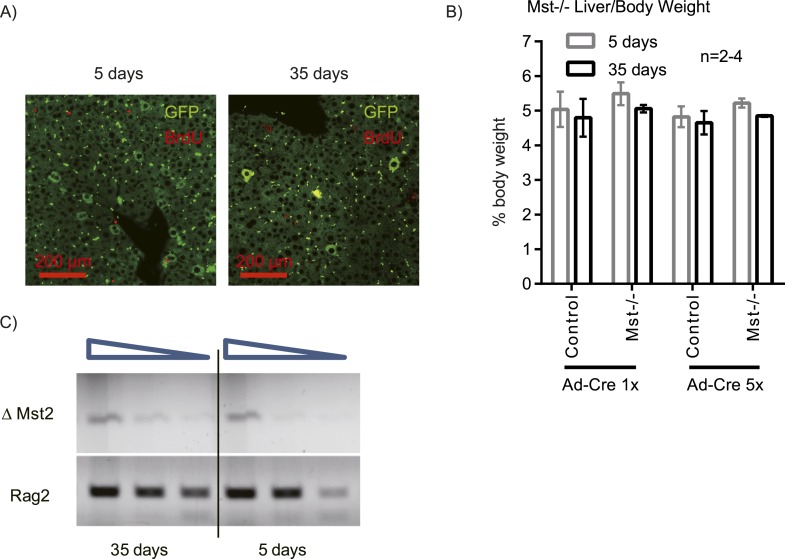
Mosaic Mst1/2 loss does not induce hepatocyte expansion or liver size increase.Stk4−/−;Stk3flox/flox (Mst1/2) mice were injected with a low dose adenovirus expressing Cre and GFP. (A) Livers were harvested 5 and 35 days after Ad-Cre-GFP injection; BrdU was injected 1 day before harvesting. Liver sections were stained with antibodies to GFP and BrdU. (B) Liver/body weight ratio of Mst1/2 mice injected with Ad-Cre-GFP at the dose shown in A (5×) or fivefold lower dose (1×). (C) Semi-quantitative analysis of the deleted Stk3 (∆Mst2) allele in liver genomic DNA of Mst1/2 mice harvested 5 or 35 days after low dose Ad-Cre-GFP infection. Rag2 genomic PCR was used as a loading control. The triangle denotes serial dilutions of the template DNA (fourfold). Representative images are shown (repeated twice; n > 3/group in each).